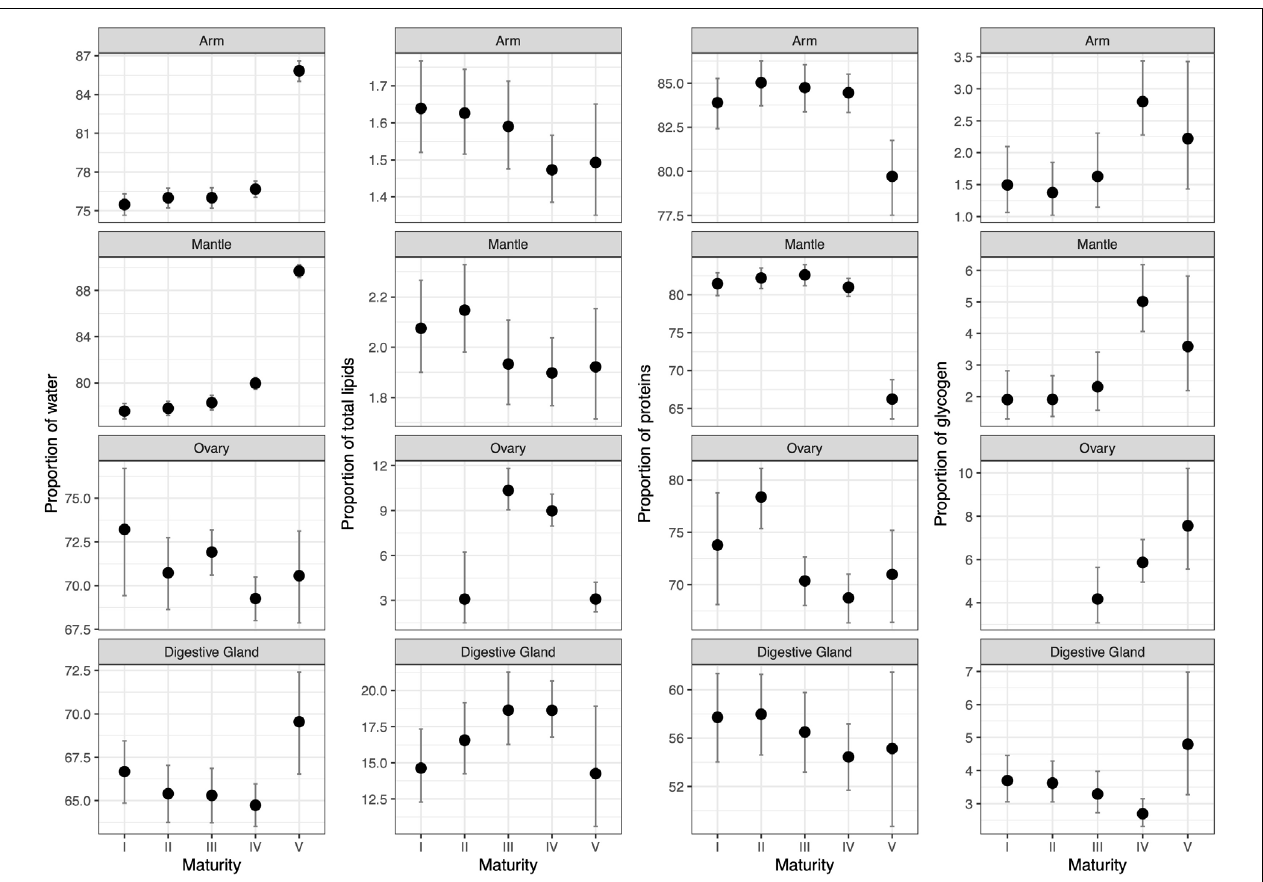
FIGURE 3 | Differences in the proportion of each of the four main biochemical constituents (across columns) per tissue (along rows) during the reproductive cycle once accounting for seasonality ( Supplementary Figure 3 ) and tissue weight (body for arm and mantle tissues, ovary or digestive gland log-transformed weight) ( Supplementary Figure 5 ) as obtained from fitting beta regression models. Predicted values were obtained for an individual of 1.5 kg in